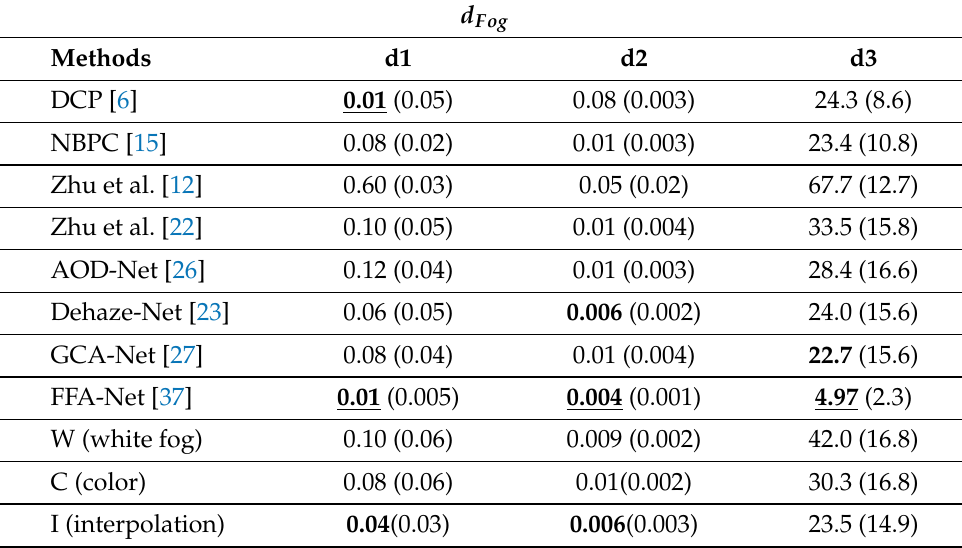
Table 5. Comparison of three distance indexes d1, d2 and d3 on fifty images from the SOTS dataset, with the d Fog index (in the fog area). W corresponds to our main algorithm assuming white fog, C to the color version, and I to the interpolation version. The two best results are in bold. The best result is also underlined.